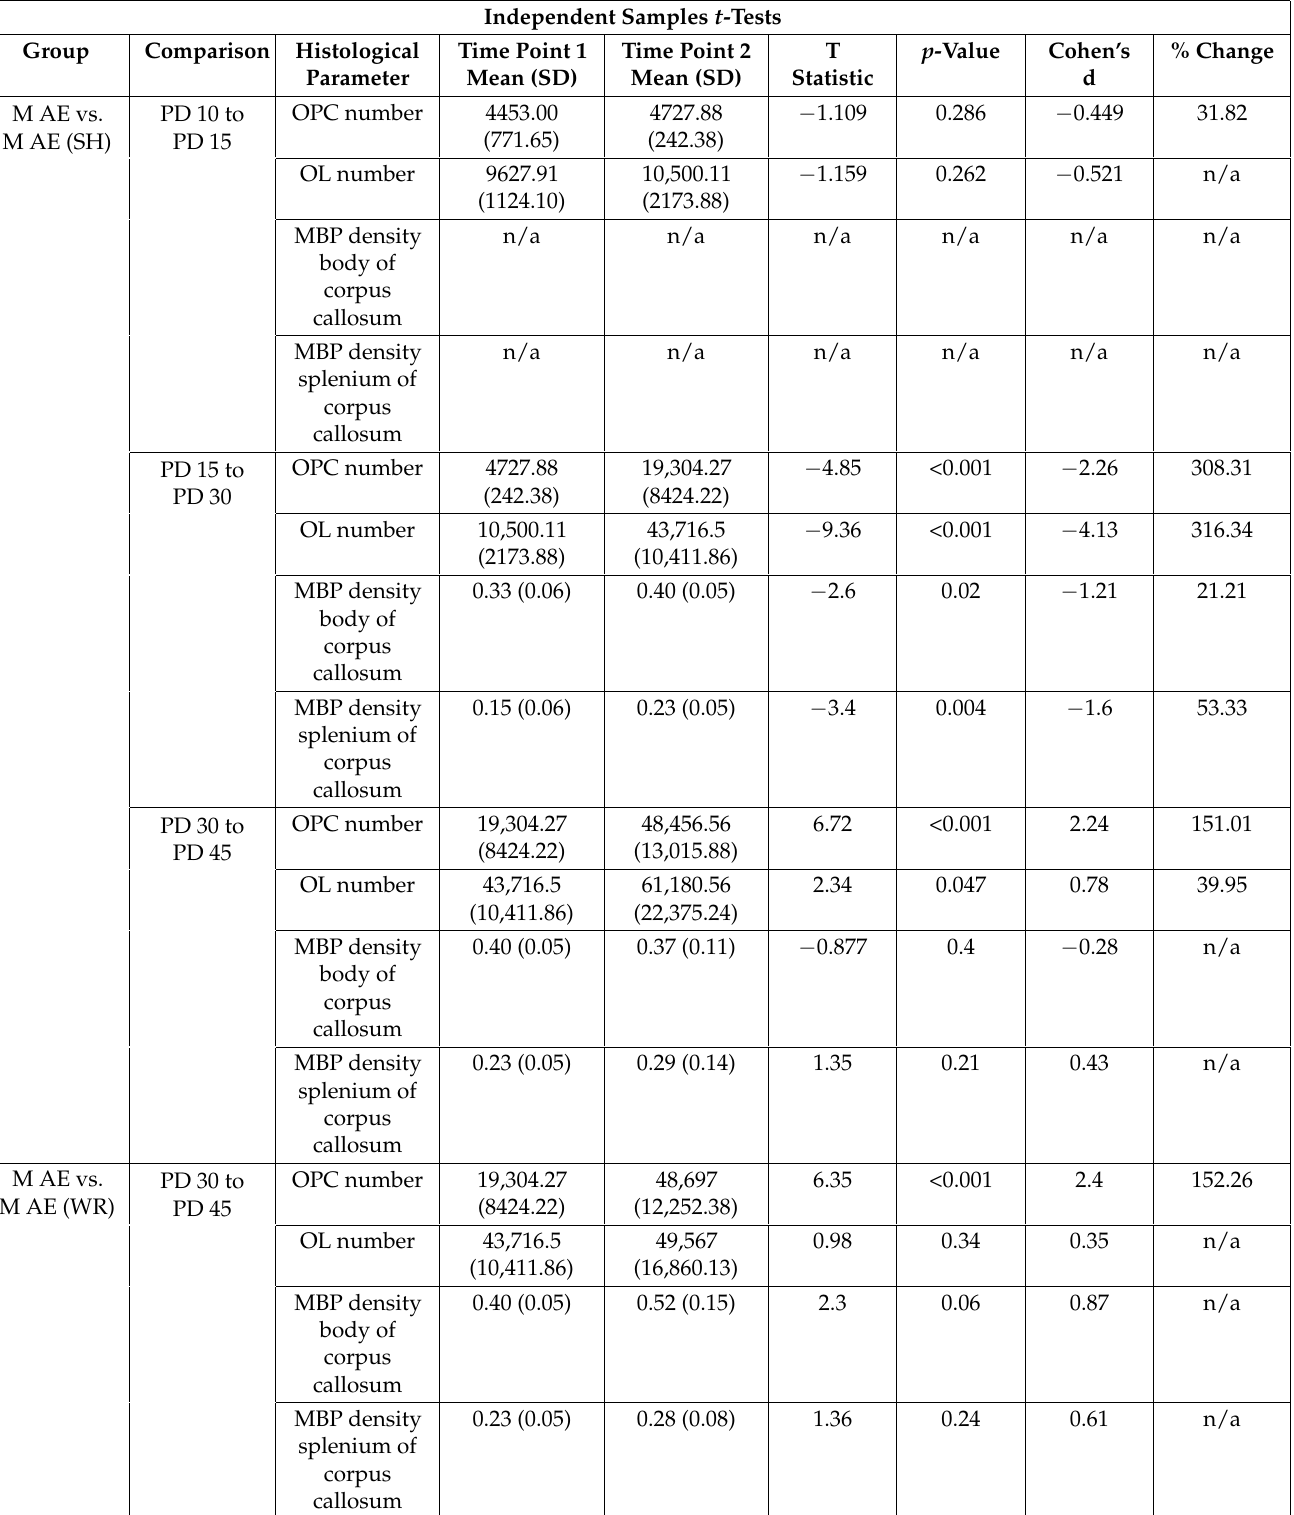
Table 2. Cont. Independent Samples t